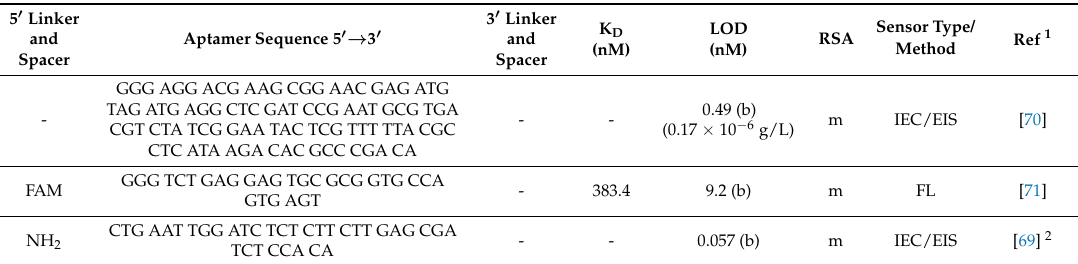
Table 2. Aptamer sequence, dissociation constant (K D ), limit of detection (LOD), real sample analysis (RSA), and realized sensor type and measuring method for penicillin G, mentioned in the corresponding references (Ref). b = buffer, EIS = electrochemical impedance spectrometry, FAM = fluorescein amidite, FL = fluorometric, and IEC = impedimetric